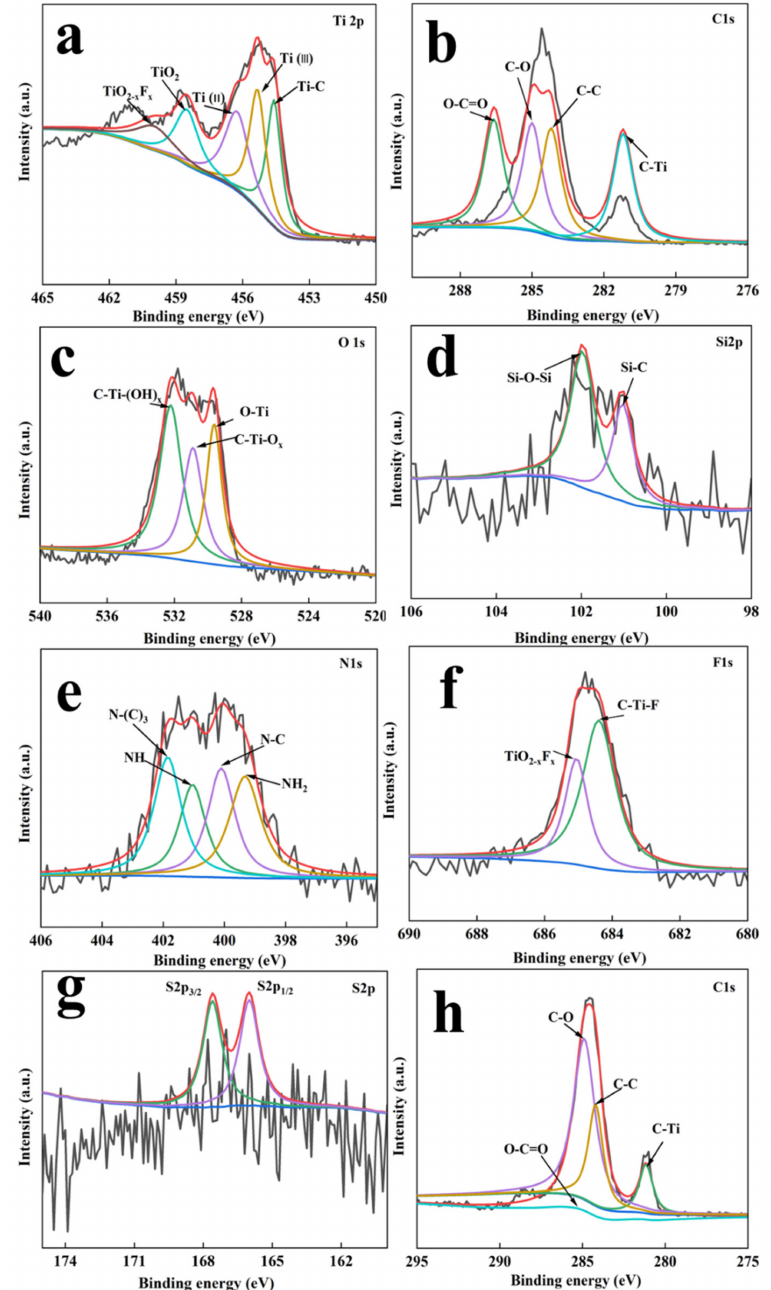
Figure 7. XPS spectra of the MXene − TK − DOX@PDA nanoparticles. ( a – g ) Ti 2p, C 1s, O 1s, Si2p, N1s, F 1s, and S 2p spectra of MXene − TK − DOX@PDA. ( h ) C 1s XPS spectrum for MXene +